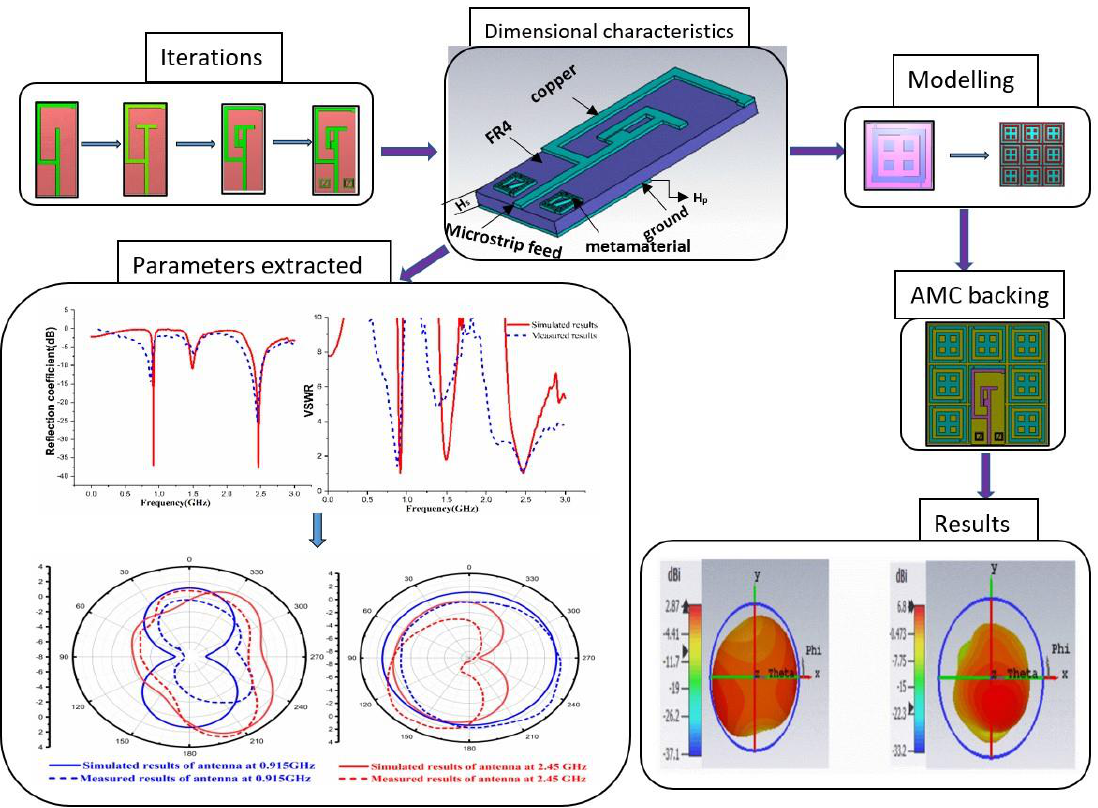
Figure 1. Overview of Design, Modelling analysis.